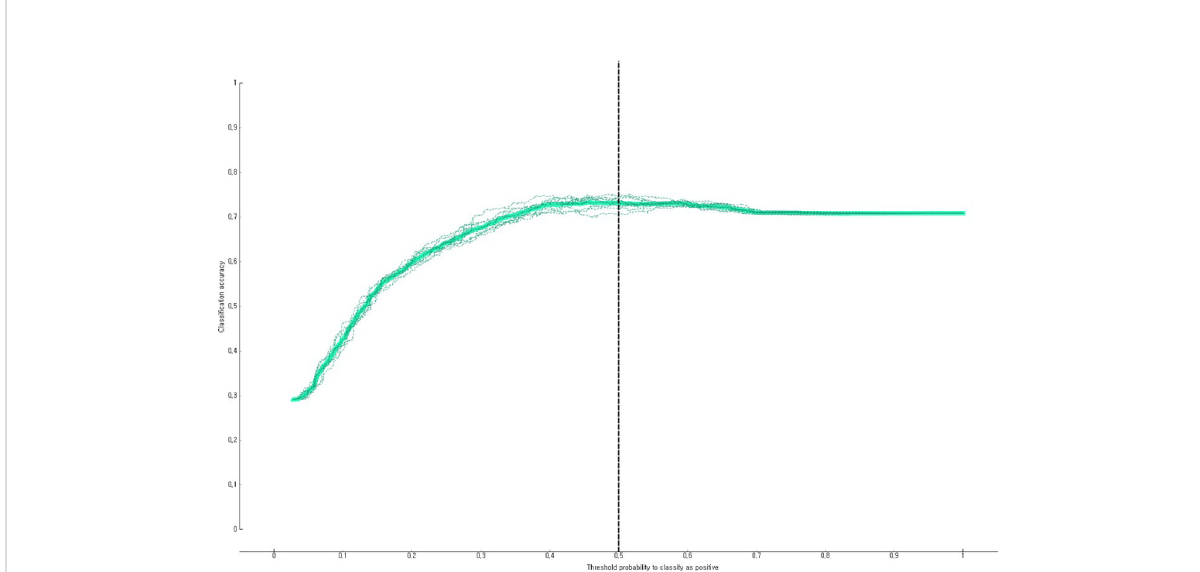
FIGURE 3 Accuracy of the nomogram for predicting impaired fasting glucose in South Korean